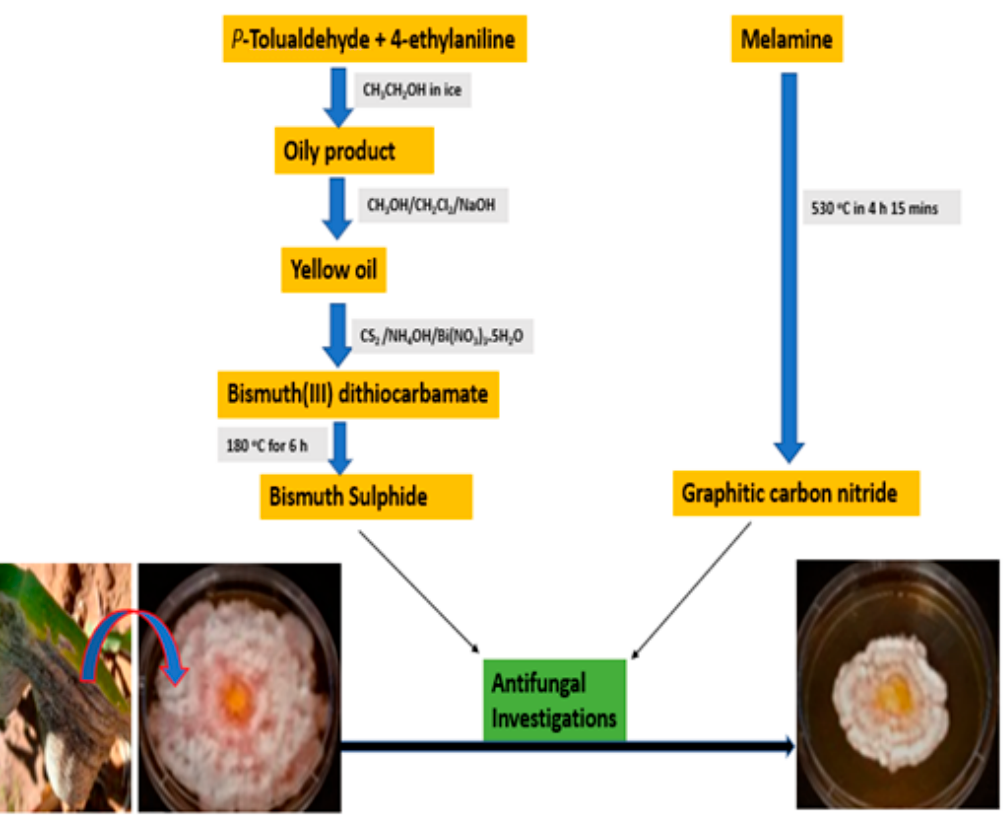
Figure 1. Synthesis of bismuth sulphide and graphitic carbon nitride used for the antifungal treatment of foliar fungi of